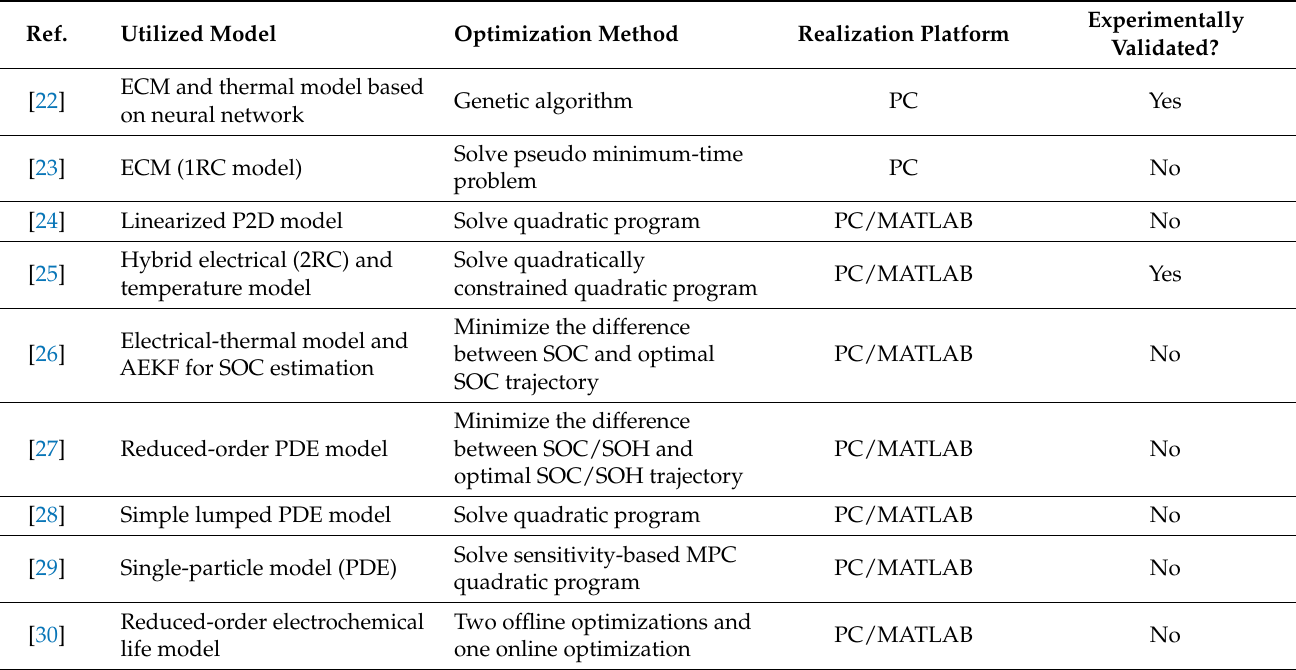
Table 1. Comparison of model predictive control (MPC) charging methods proposed in the literature.